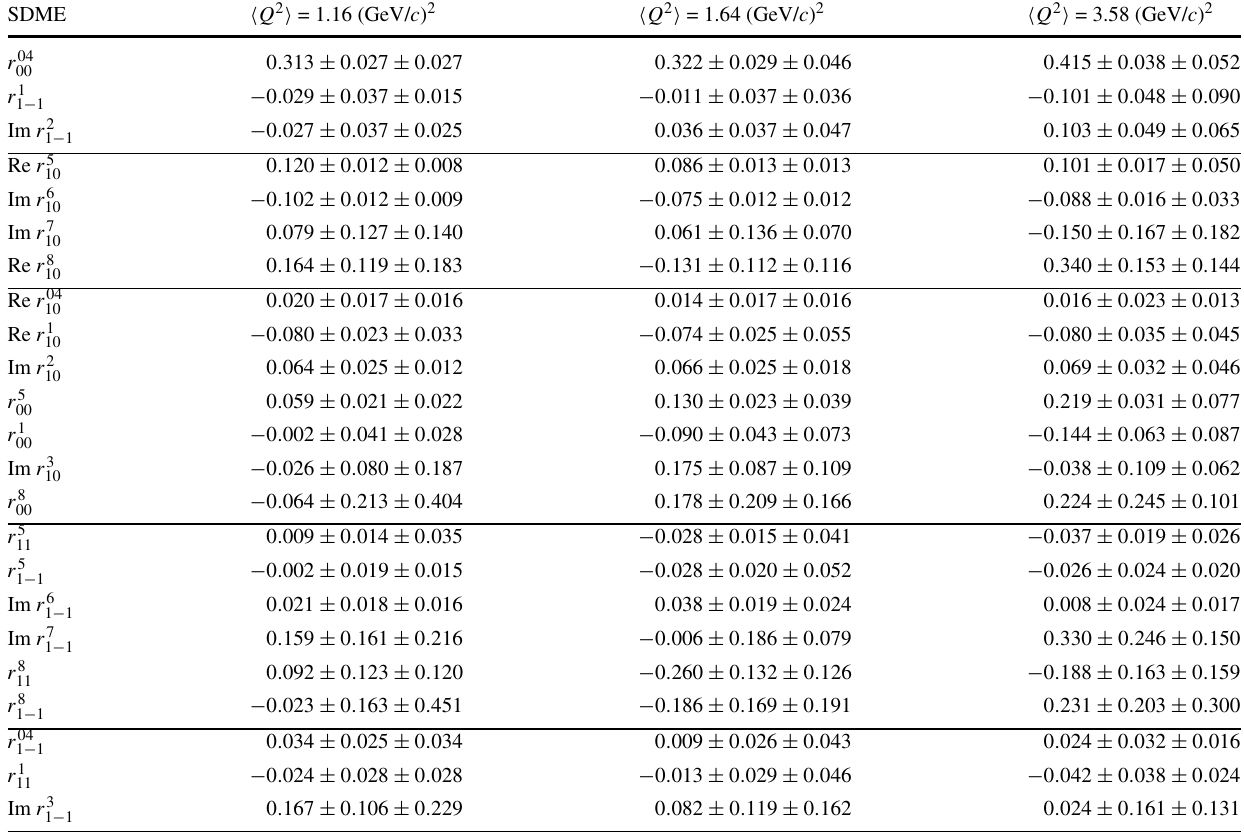
Table 5 The measured 23 unpolarised and polarised ω SDMEs in bins of Q 2 : 1 . 00 − 1 . 35 − 2 . 05 − 1 . 00 (GeV/ c ) 2 . The first uncertainties are statistical, the second systematic